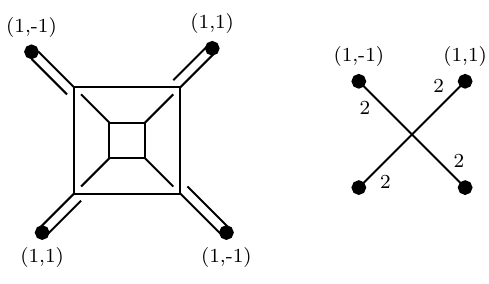
Figure 5 . Brane web for USp(4)+1 AS